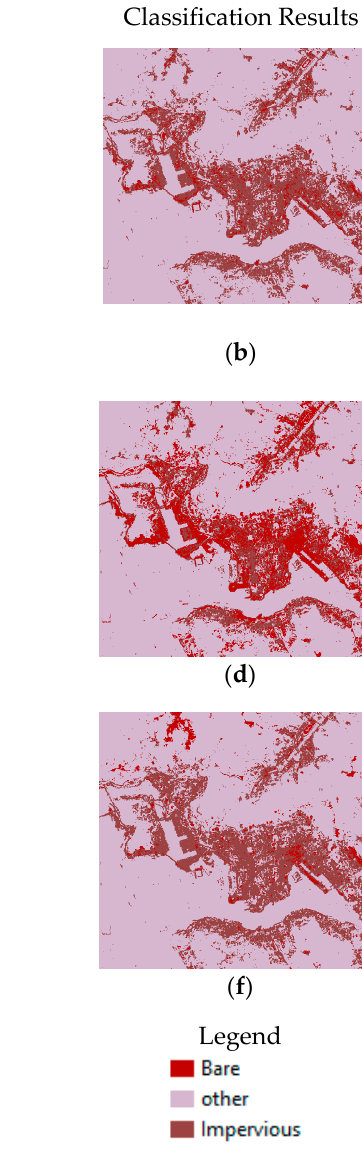
Table 4. Sensitivity of indices in the detection of impervious and bare land.